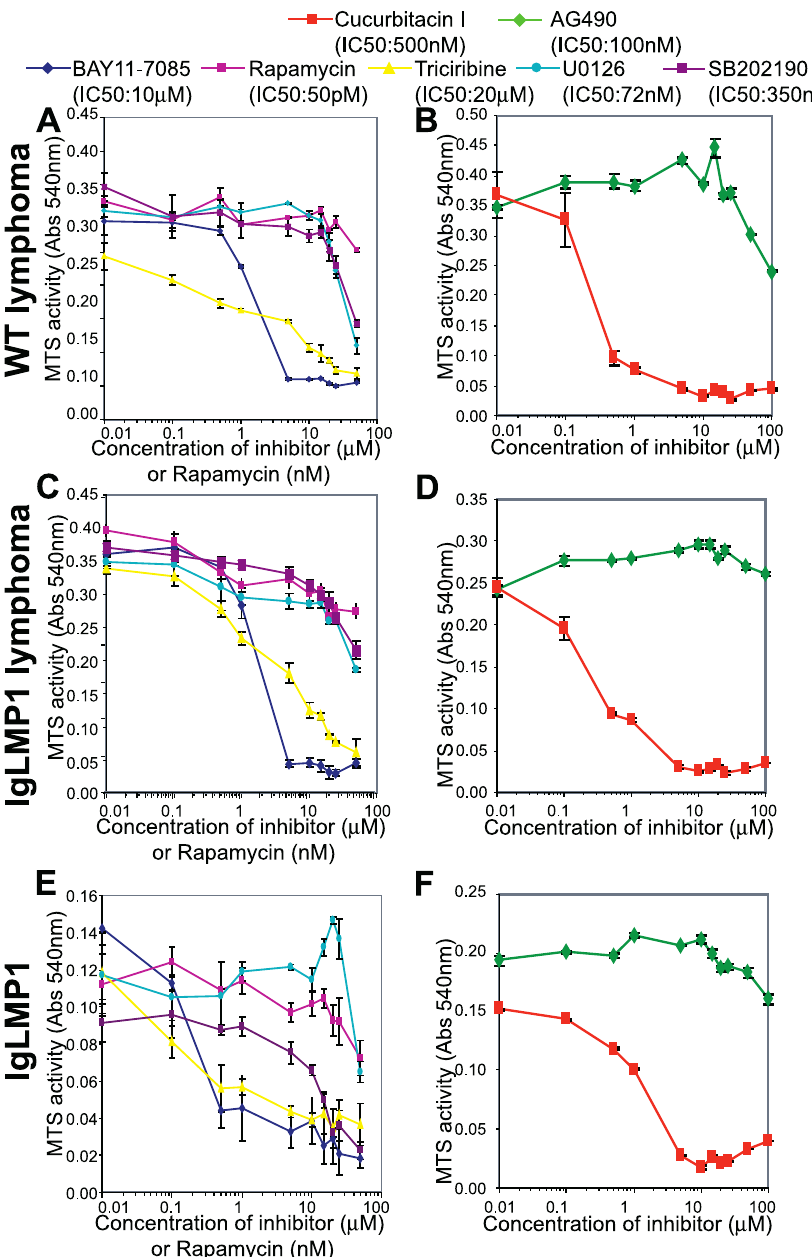
Figure 7. Akt, NF j B, and Stat3 Signaling Are Required for the Growth and Survival of Lymphoma Cells MTS assay of splenocytes from (A and B) WT or (C and D) LMP1 transgenic lymphomas and (E and F) LMP1 transgenic lymphoctyes. Splenocytes were cultured with or without inhibitors of NF j B (BAY11), mTOR (rapamycin), Akt (triciribine), MEK1/2 (U0126), p38 (SB202190), or Stat3 (cucurbitacin I and AG490) at the indicated concentrations. The results are the mean 6 SEM of triplicate samples. Shown are the results for (A and B) WT lymphoma 1, (C and D) LMP1 transgenic lymphoma 2, and (E and F) one out of two LMP1 transgenic mice analyzed. This analysis was repeated with LMP1